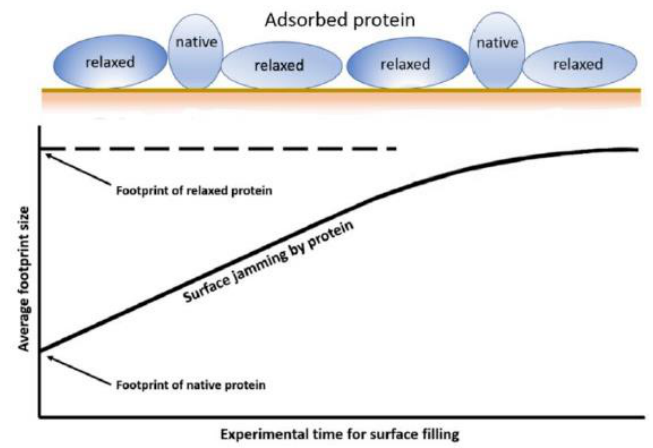
Figure 3. Schematic of progressive relaxation of adsorbed protein layer and increase in surface occupancy per molecule over time. Amount of protein needed for total confluent coverage (jamming) of surface is reduced as time of experimental observation increases. Adapted from [40].